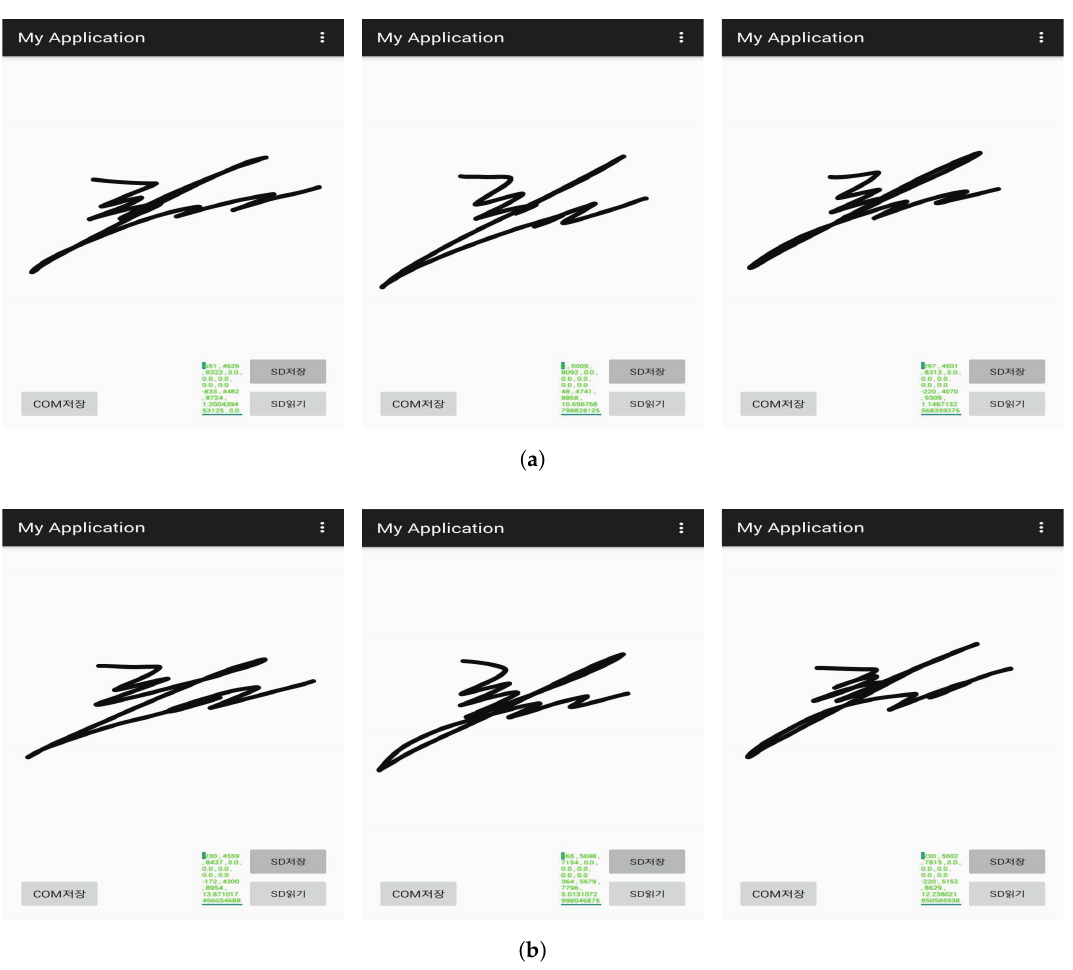
Figure 7. Samples of: ( a ) original signatures; and ( b ) forged